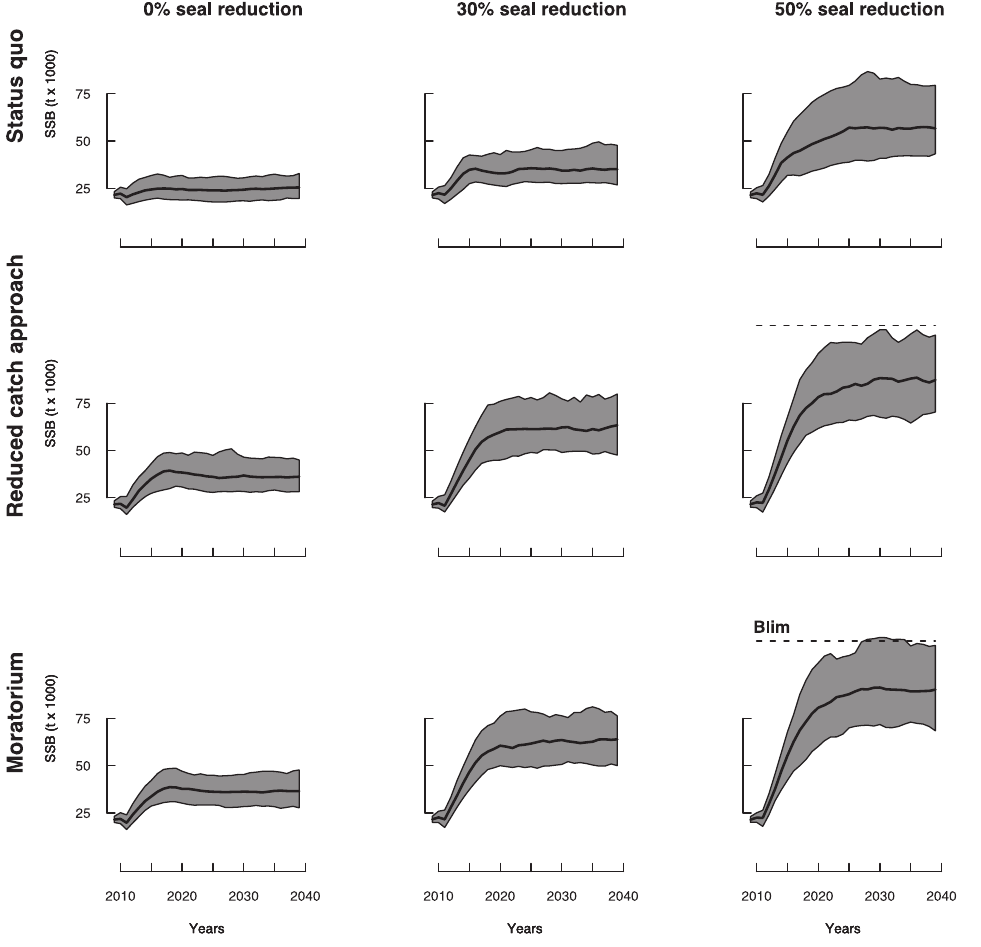
Figure 6. Cod SSB forecast in years 2010–2040 under water cooling conditions (cold intermediate layer (CIL) anomaly= 2 0.5 u C). Plain lines and grey areas indicate median values and 90%-confidence domains, respectively. The dashed line indicate the limit of recruitment overfishing B lim .